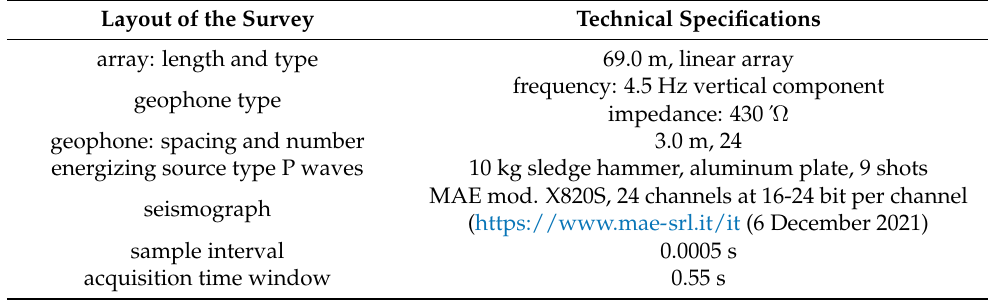
Table 1. Characteristics of the Seismic Refraction